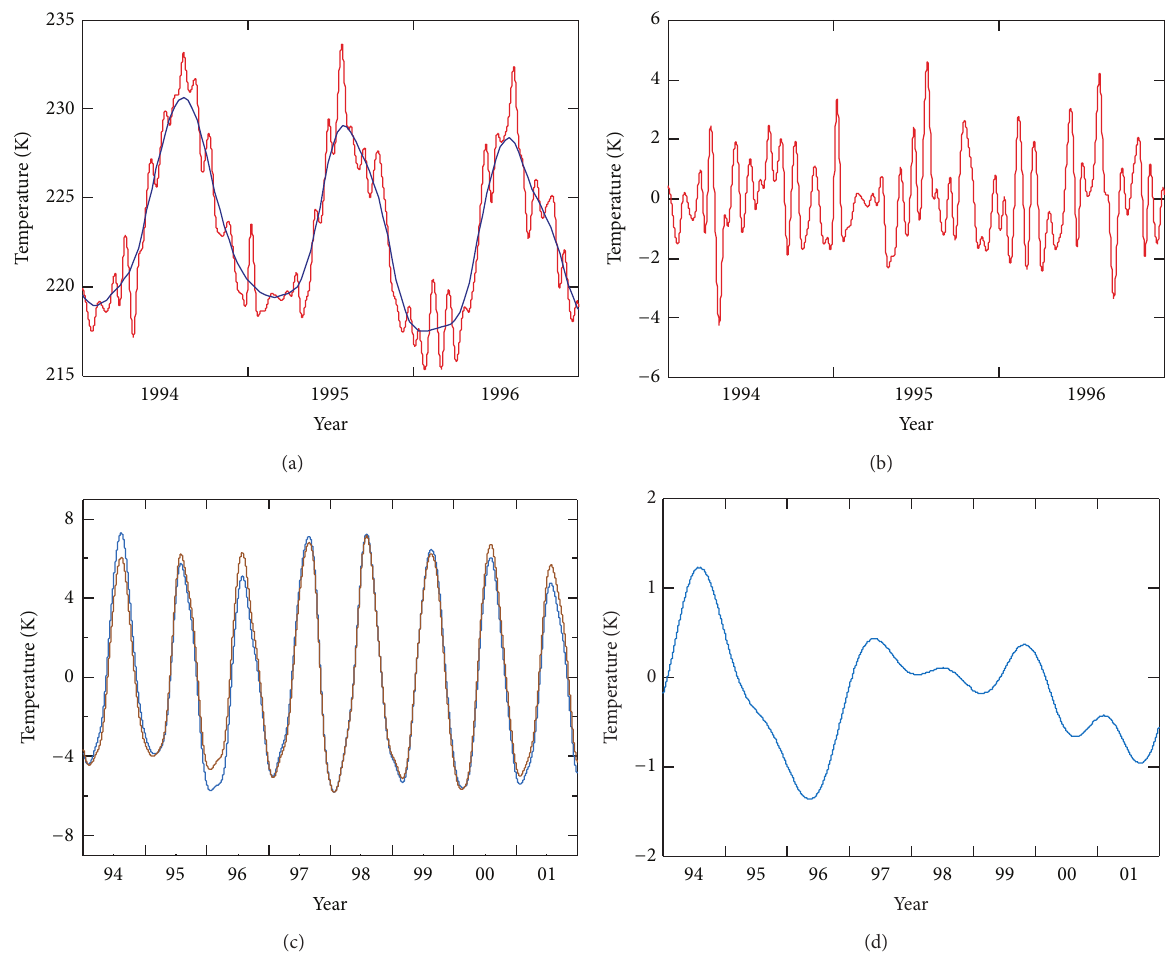
Figure 2: Illustration of the preliminary data processing as applied to the data at 10km altitude. Panel (a) presents the 10-day averaged temperature data (red curve) and the corresponding long-period march (blue curve), while the difference between two curves that is considered to represent the intra-annual variations is given in panel (b). Panel (c) shows detrended long-period variations presented by the azure curve and the oscillations, composed of lower than 1-year cycles (brown curve). The difference between them, given in panel (d), can be associated with the interannual